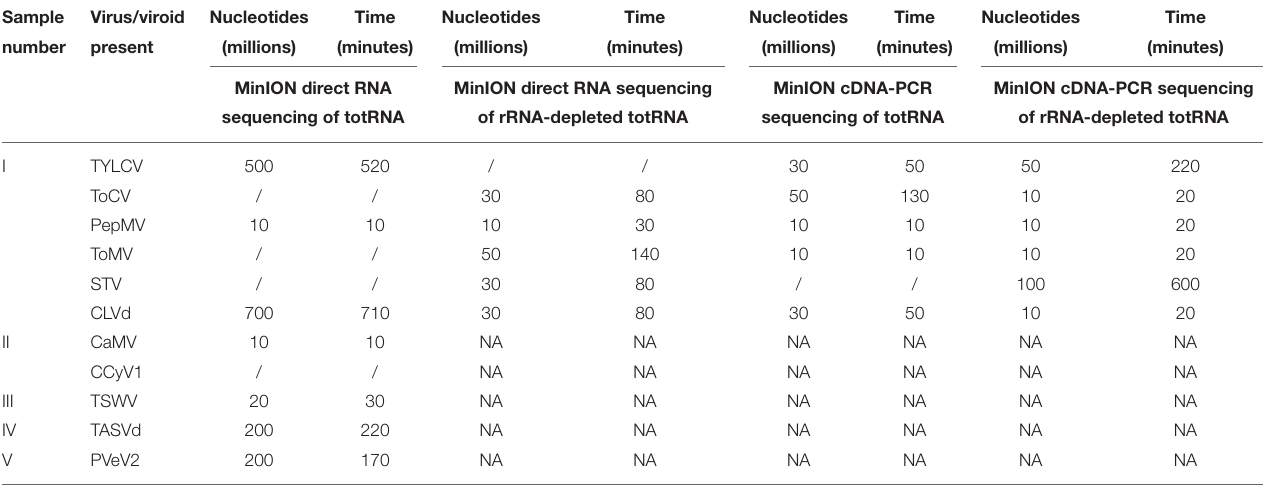
TABLE 2 | Cumulative yield of nucleotides sequenced in time.